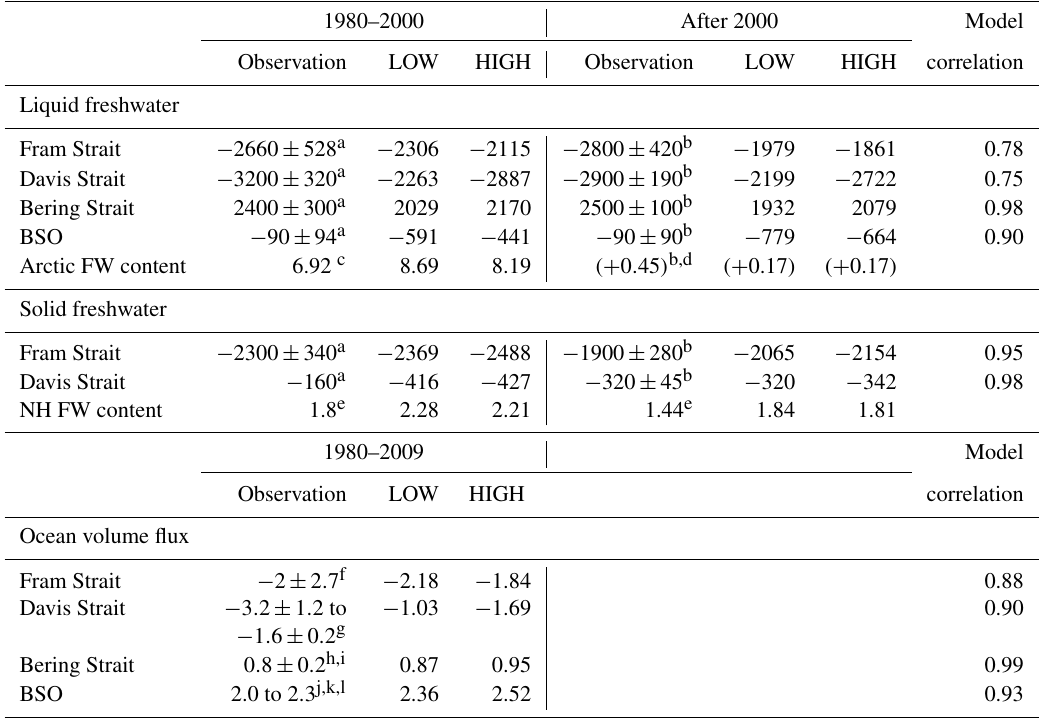
Table 1. Arctic Ocean liquid and solid FW budgets relative to a reference salinity of 34.8, and the net ocean volume transport through Arctic gateways. The FW budget terms are shown for the periods 1980–2000 and 2000–2009 separately. The correlation coefficients for fluxes obtained from the two simulations (LOW and HIGH) are shown for the period of 1980–2009 in the last column, and all correlations are significant at the 95% level. Liquid FW contents for the 2000–2009 period are shown with the changes relative to the 1980–2000 period. FW fluxes are shown in km 3 yr − 1 , FW contents are in 10 4 km 3 , and ocean volume transports are in Sv. Positive fluxes indicate sources for the Arctic